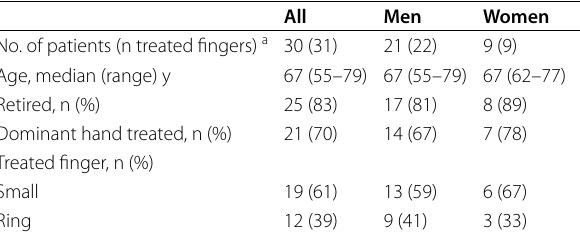
Table 1 Patient